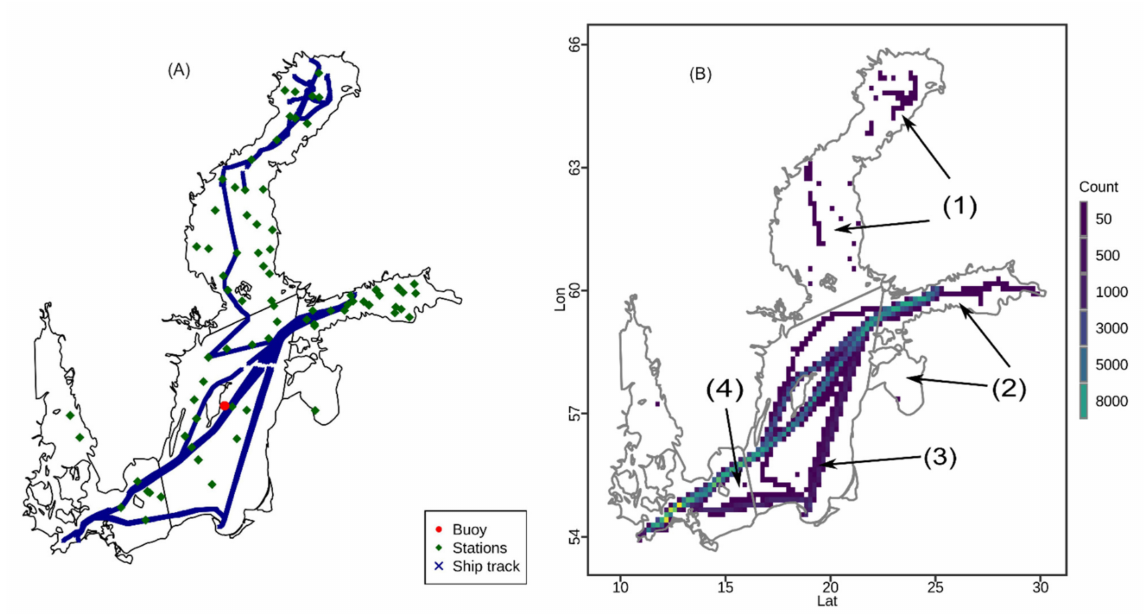
Figure 1. The location where the in-situ pCO 2 were measured in the Baltic Sea from August 2002 to November 2011 ( A ) and the density distribution of the in-situ pCO 2 measurements ( B ). The numbers in parentheses indicate the sub-basins where the variables’ importance was analyzed. (1) Gulf of Bothnia, including Bothnia Bay (north) and Bothnia Sea (south); (2) Gulf of Finland (north) and Gulf of Riga (south); (3) Baltic Proper; (4) Arkona